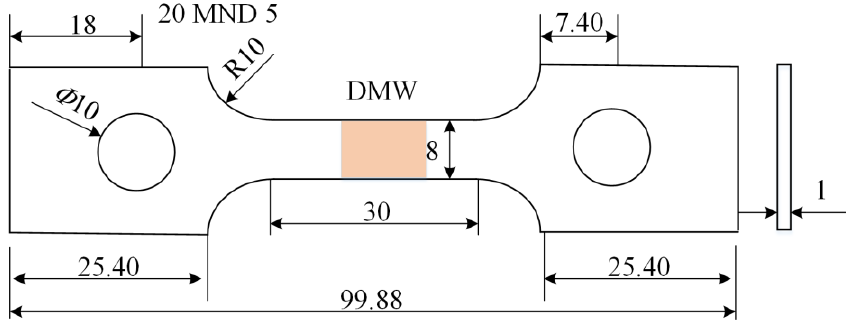
Figure 3. The dimensions of a uniaxial tensile SF specimen for a DMW joint.